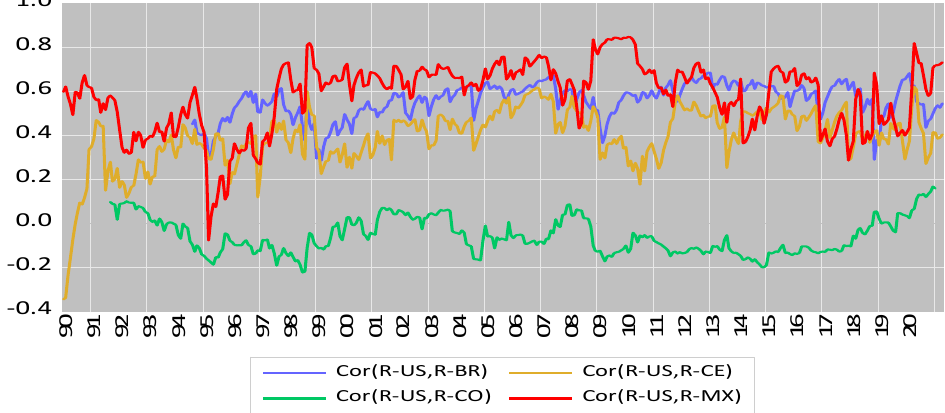
Figure 3. Plots of dynamic correlation coefficients for U.S. and Latin America markets. The statistics in Table 8 show the mean values of correlation coefficients across different Table 8. Summary statistics of dynamic correlation coefficients for U.S. and global stock market returns. markets vary from − 0.0573 (Columbia) to 0.7616 (UK). The maximum values for the majority of markets, especially with Canada, lie between the period of April 2020 and May 2020, the peak period of COVID-19 spread. The minimum values are more diverse: some occur in the early 1990s, the U.S. dot.com collapse; others occur in 1997–1998 due to the impact of the Asia crisis. The values of standard deviations of the correlated coefficients